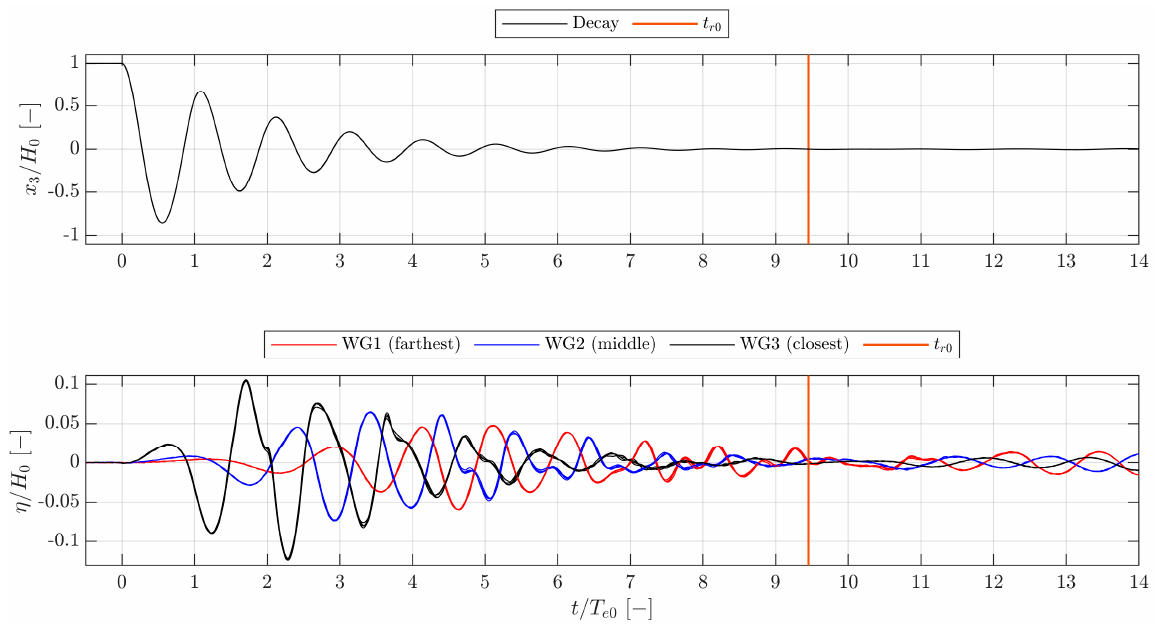
Figure 19. Decay and surface elevation time series for H 0 = 0.5 D